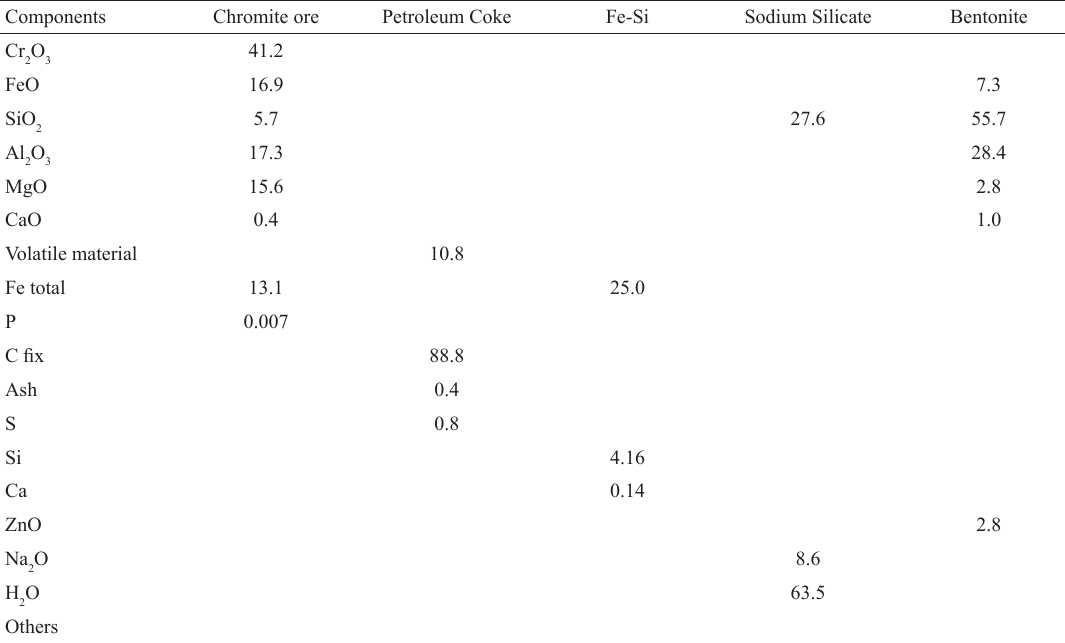
Table 1: Chemical composition of the materials (wt%) Components